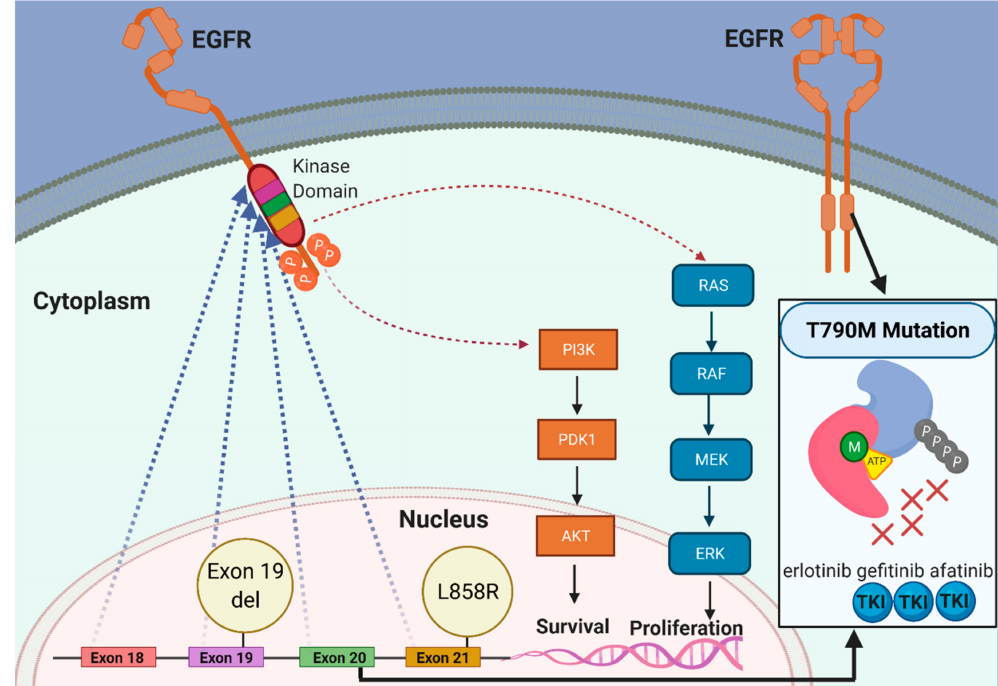
Figure 3. The biology of EGFR mutations in lung cancer. In normal cells, binding of a ligand causes dimerization of EGFR which leads to downstream activation of several pathways such as PI3K/AKT and MAPK/RAF which control cell growth and proliferation. In EGFR-mutated lung cancer, activating somatic mutations in exons 18–21 can lead to constant activation of the EGFR kinase domain with continuous downstream signaling through PI3K/AKT and MAPK/RAF pathways irrespective of ligand binding to growth hormones. This can lead to cell survival, proliferation and resistance to apoptosis. The most common EGFR mutations are exon 19 deletions and a point mutation in exon 21 (L858R). The presence of the point mutation T790M in exon 20 leads to resistance to first- and second-generation EGFR TKIs due to a higher affinity of the ATP-binding pocket in the EGFR to ATP and a lower affinity to first- and second-generation EGFR TKIs such as erlotinib, gefitinib, afatinib, and